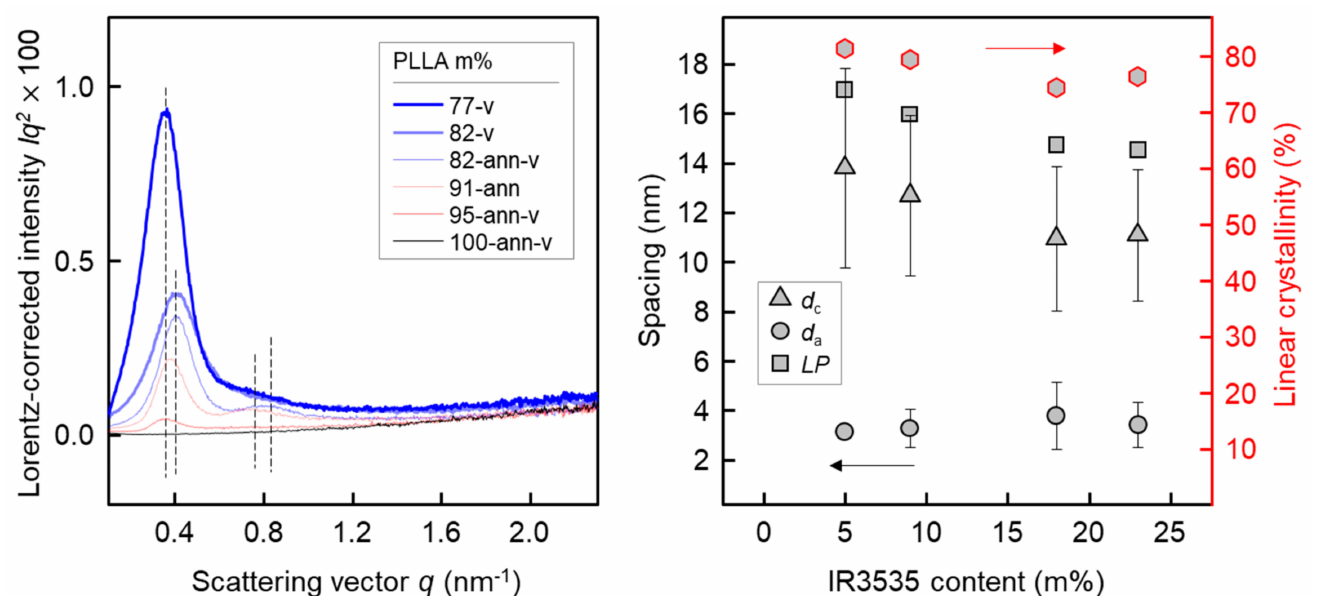
Figure 7. Lorentz-corrected SAXS curves of PLLA/IR3535 extrudates of different composition as indicated in the legend, stored at room temperature for about 9 months and annealed at 60 ◦ C for 3–4 weeks, respectively ( left ). Long period ( LP ), and thickness of lamellae ( d c ) and amorphous regions in lamellar stacks ( d a ) as a function of the concentration of IR3535 in annealed PLLA/IR3535 extrudates ( right ). The red symbols represent the linear crystallinity (right axis). The bars represent the distribution of d c and d a